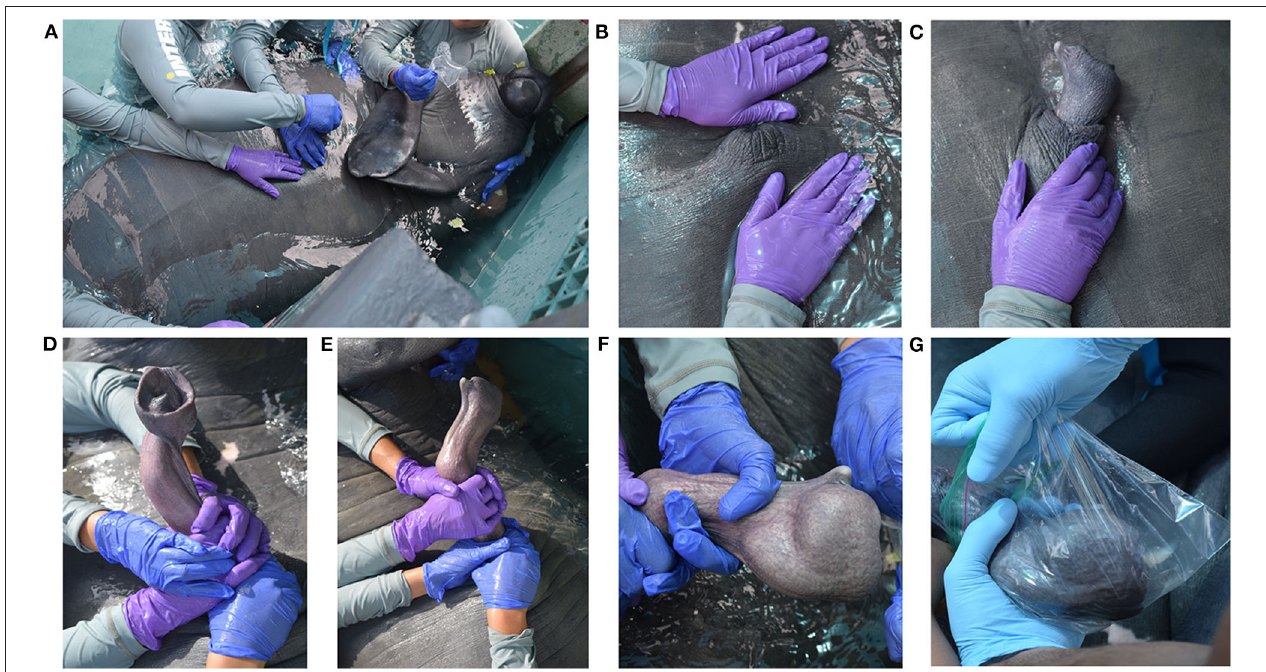
FIGURE 1 | Manual semen collection in a captive male West Indian manatee. (A) The male is positioned at the edge of the pool with his ventral side above the water and his body supported by in-water trainers. (B,C) The male receives tactile stimulation to the genital region until partial extrusion or a full erection is achieved. Tactile stimulation is focused on the mid-shaft region and glans penis to elicit the best stimulatory response. (D,E) The penis enters a pre-ejaculatory state characterized by the formation of a penile cup at the distal end of the penis and a bulbis glandis along the midshaft of the penis. (F) The penile cup becomes increasingly engorged as the male approaches ejaculation. (G) Upon ejaculation, semen is collected into a clear plastic bag for immediate processing and